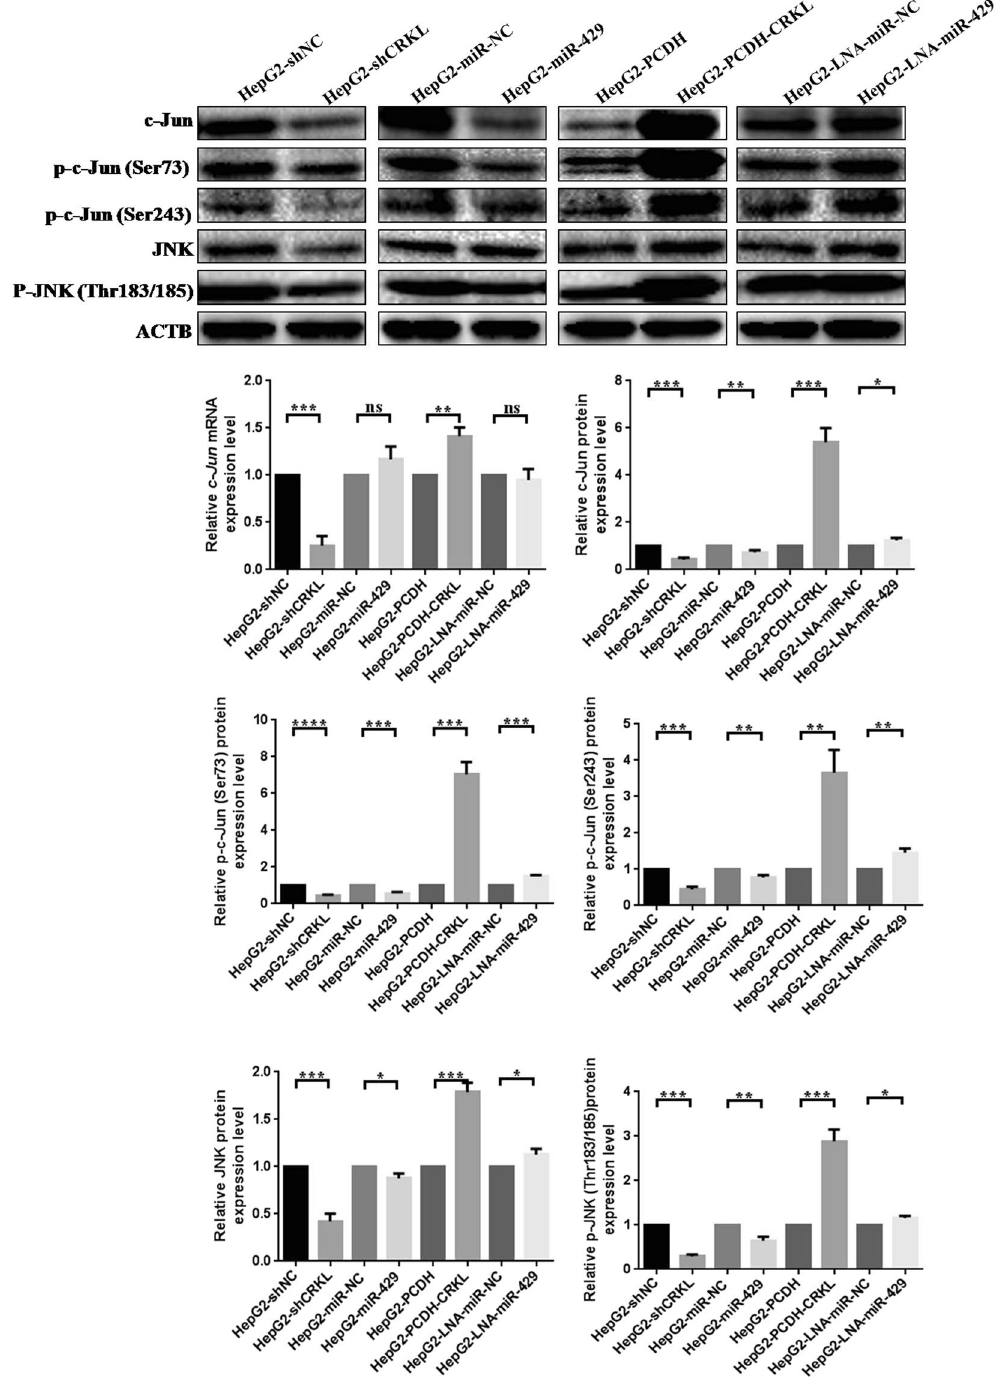
Figure 10. The influences of miR-429 and CRKL on c-Jun pathway in HepG2 cells. WB detected the protein expression level of c-Jun, p-c-Jun (73), p-c-Jun (243), JNK, p-JNK in HepG2 cells transfected with miR-429 mimic, miR-429 inhibitor, shCRKL or PCDH-CRKL. qRT-PCR also detected the mRNA expression level of c-Jun in HepG2 cells transfected with miR-429 mimic, miR-429 inhibitor, shCRKL or PCDH-CRKL. * , ** , *** and **** refer to the level changes were in statistical significances with P < 0.05, 0.01, 0.001 and 0.0001, respectively, ns refers to no statistical